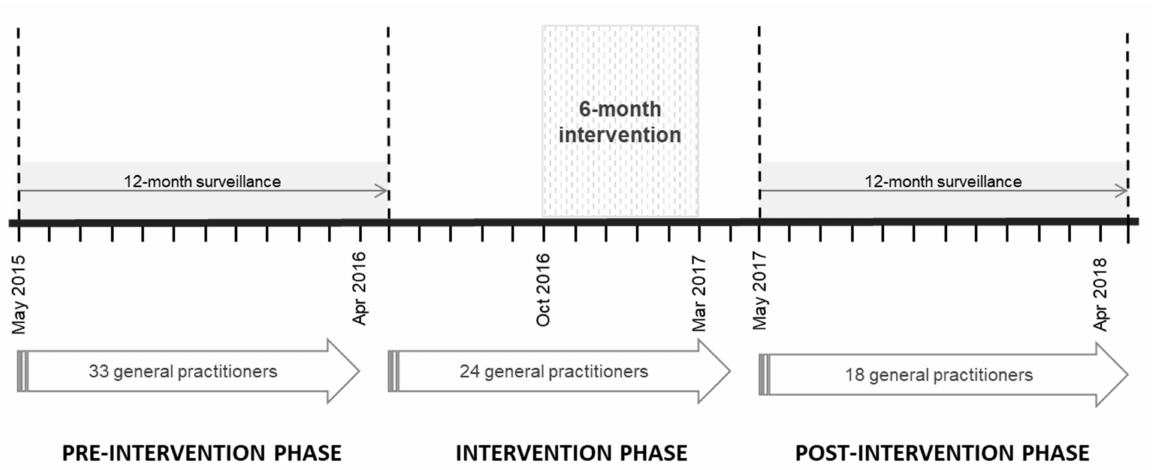
Figure 4. Surveillance and intervention timeline, including general practitioner participation at each